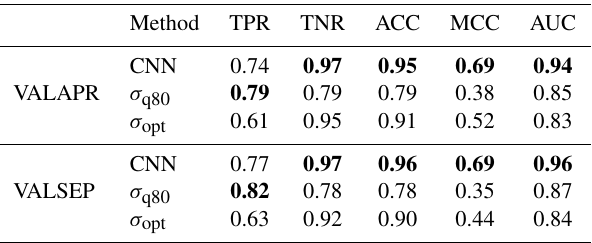
Table 2. Performance metrics of rain event detection methods on VALAPR and VALSEP. Best performances for the individual met- rics are highlighted